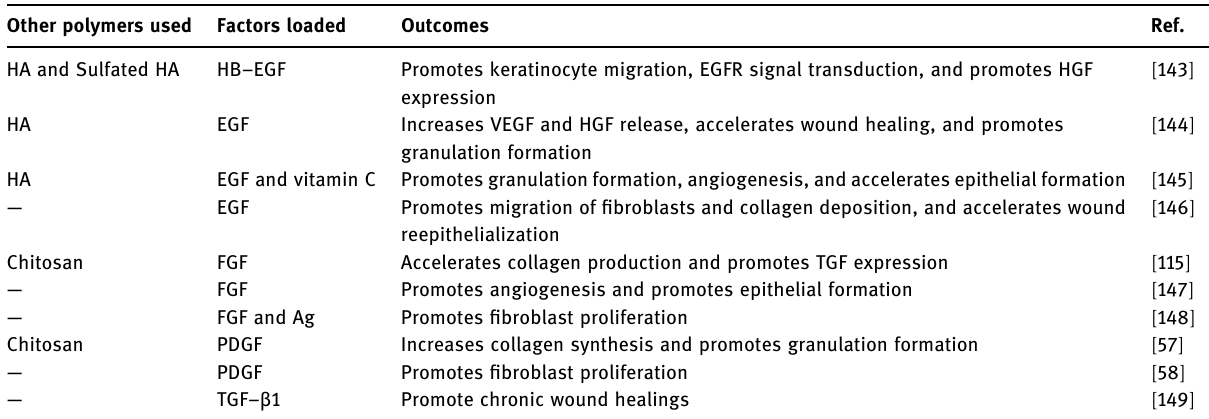
Table 4: Summary of collagen loaded with growth factors in wound healing Other polymers used Factors loaded Outcomes